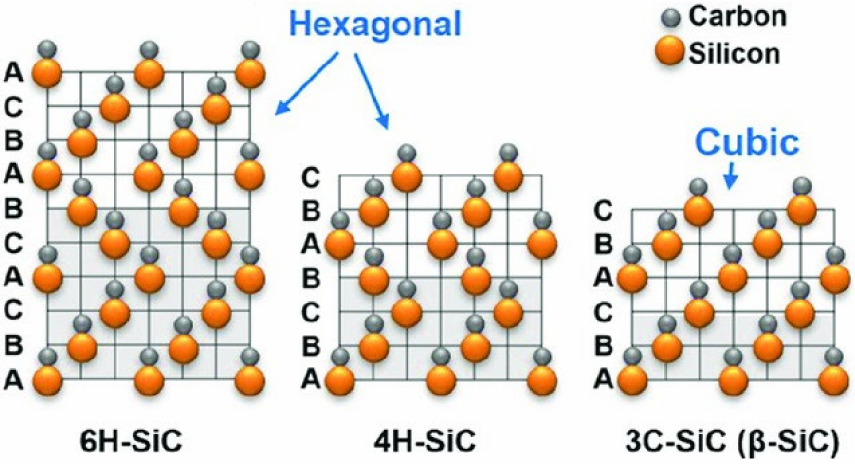
Figure 1. The staking sequences of SiC polytypes: 4H-SiC, 6H-SiC, and 3C-SiC